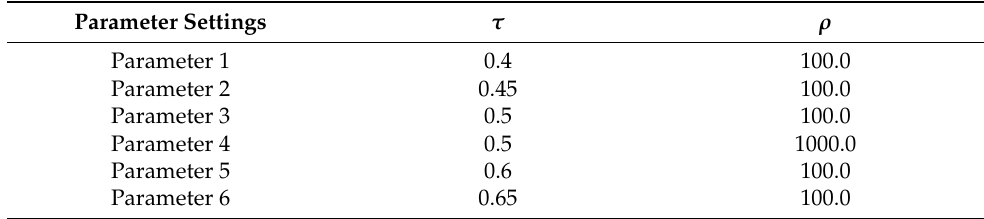
Table 5. Different parameter settings on the CWRU data set.